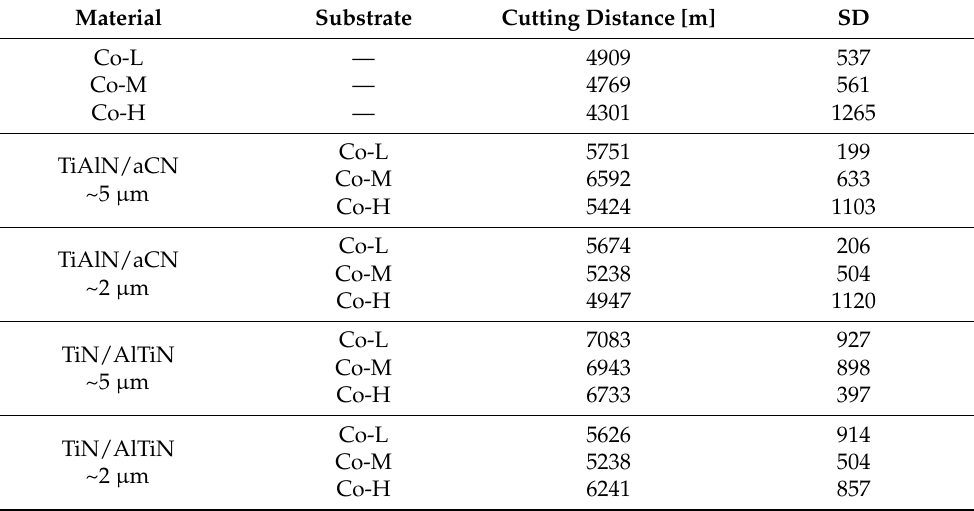
Table 7. Durability test results of TiN/AlTiN and TiAlN/a-C:N coatings deposited on different